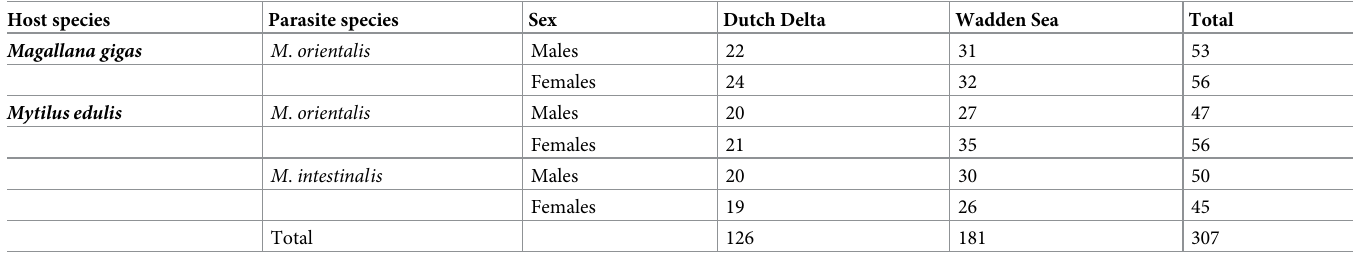
Table 1. Sample sizes of introduced Mytilicola species in different